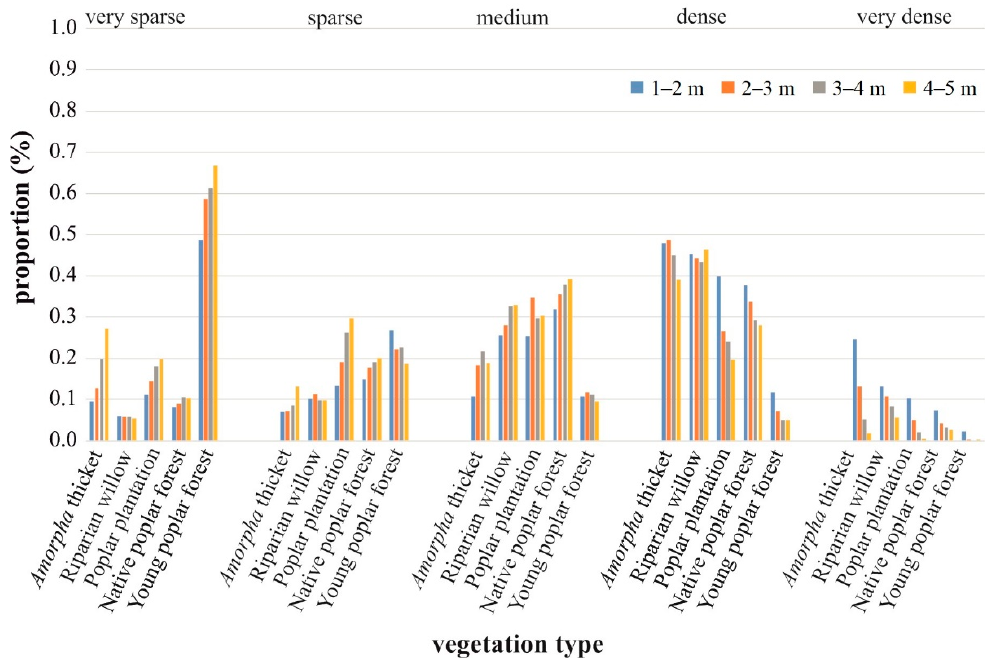
Figure 10. Distribution of various density classes at the identified vegetation types and considering the height zones of the understory.